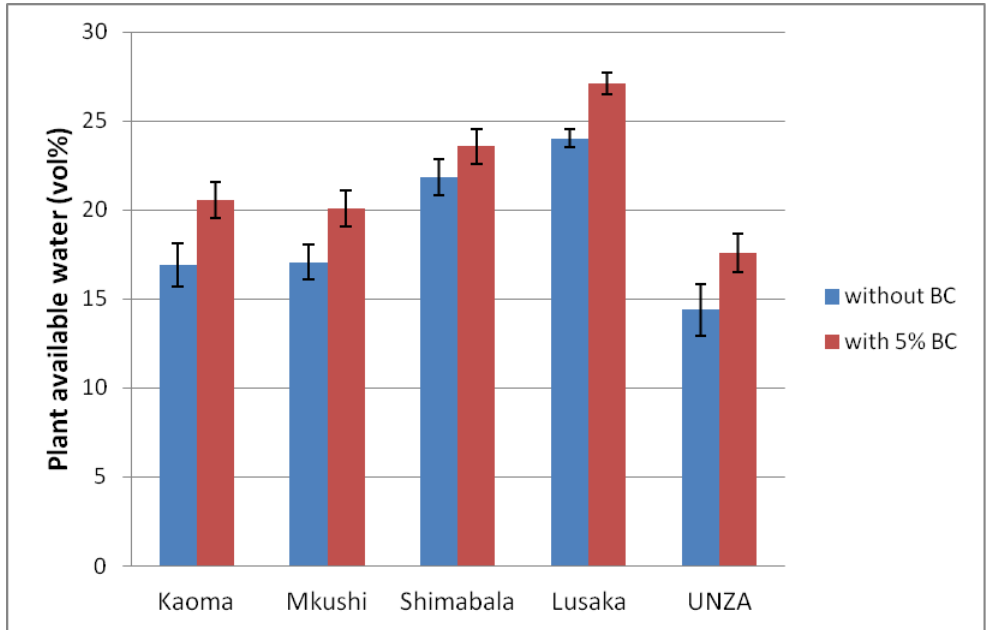
Figure 3. Plant-available water with (red bars) and without (blue bars) 5% maize cob biochar, for the five soils in hand-packed cylinders with mixed-in biochar. Plant-available water was determined as the difference in water content between pF = 2 and pF = 4.2.